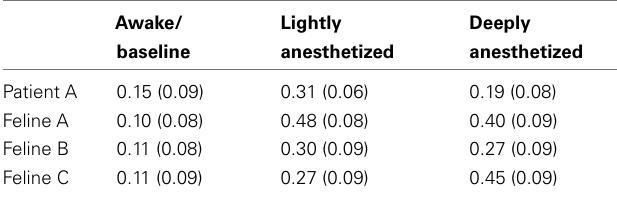
Table 4 | Probability that minimum value of the LFP would occur within 50ms of anAP for all